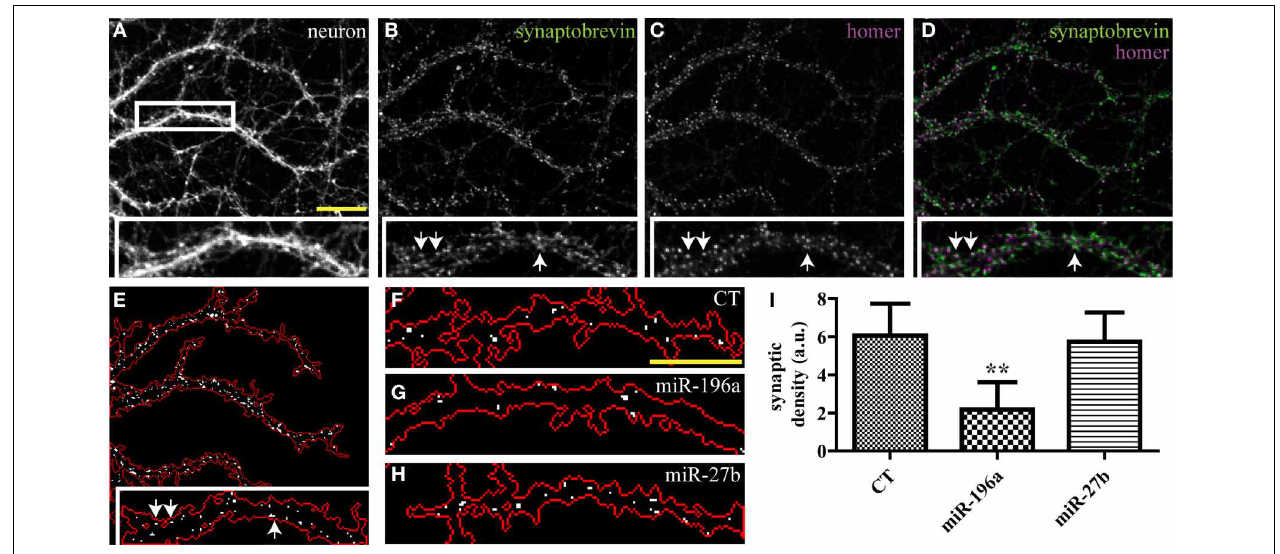
FIGURE 5 | Quantifying the impact of miRNAs on endogenous synapses in mature hippocampal neurons. Hippocampal neurons were transduced with viruses expressing the empty vector (CT), miR-196a, or miR-27b, and immunostained (DIV21) against pre- and post-synaptic markers. (A–C) Raw confocal images (63 × ) of DIV21 hippocampal neurons. Scale bar, 5 µ m. Inset, magnified view of boxed area. (D) Merged image of SV protein synaptobrevin